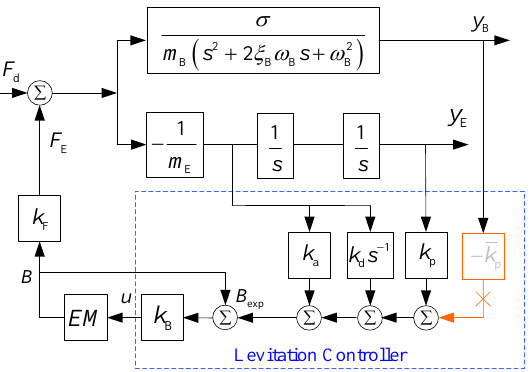
Figure 5. The block diagram of maglev vehicle-bridge system.